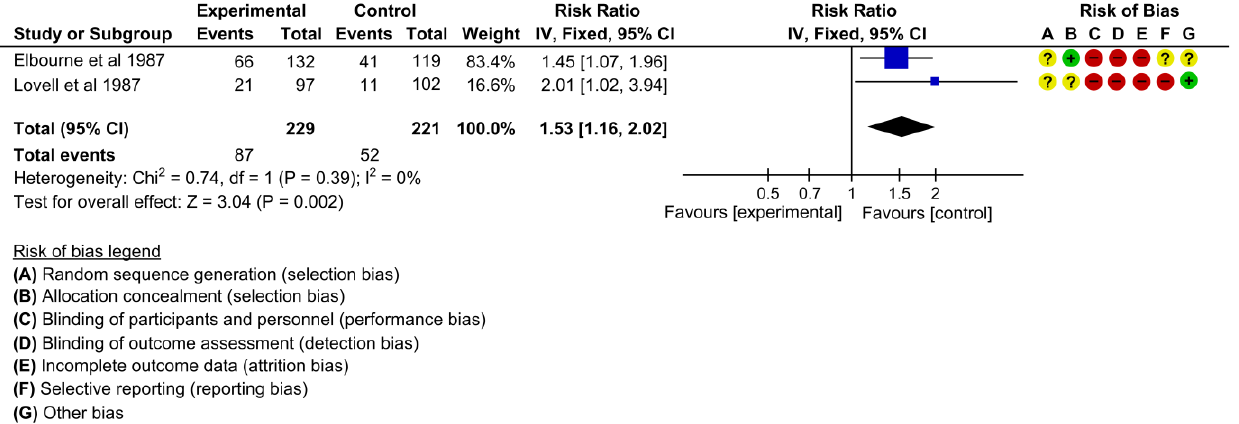
Figure 14. Meta-analysis for the effect of MCH handbook interventions vs. standard care on women felt in control during ANC [22,25]. Red color with a − symbol means a high risk of bias, yellow color with a ? symbol means an unclear risk of bias, and green color with a + symbol means a low risk of bias.